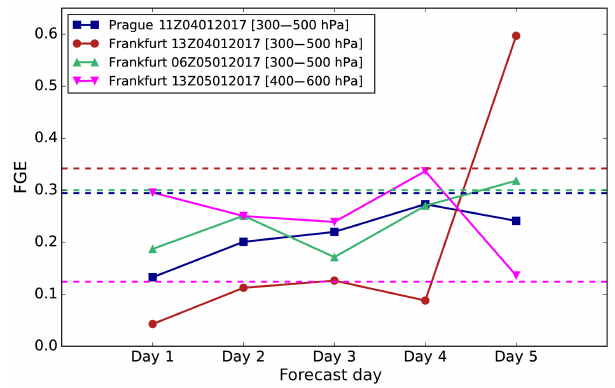
Figure 12. FGE values of IFS ozone for forecast days 1–5 over Prague (11:00Z on 4 January 2017) and Frankfurt (13:00Z on 4 January 2017, 06:00Z on 5 January 2017 and 13:00Z on 5 Jan- uary 2017). The dashed coloured horizontal lines represent the FGE values of IFS no DA ozone for forecast day